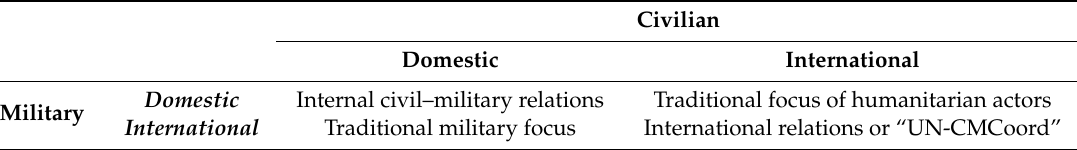
Table 1. Civilian–military collaboration on disaster